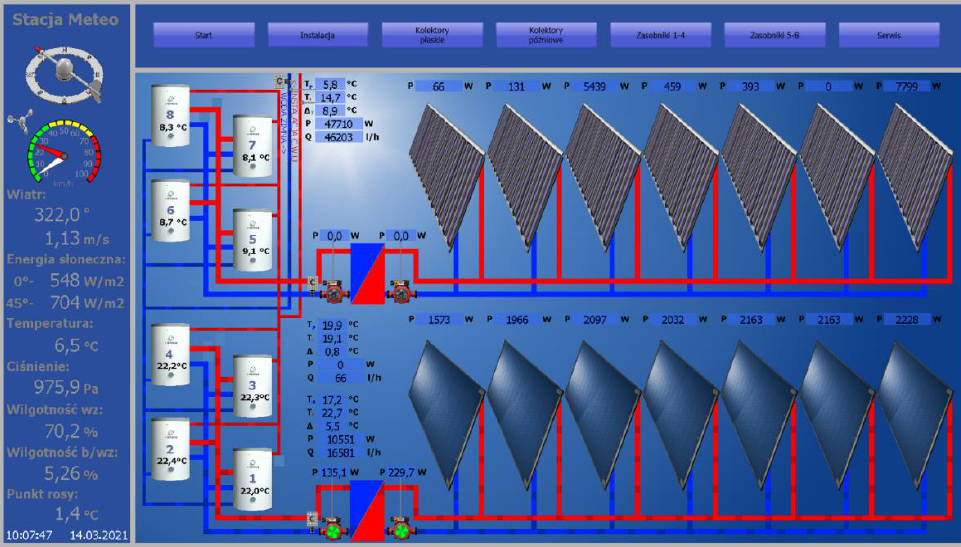
Figure 2. The screenshot of the scheme of the of SDHW system and working online data acquisition system.